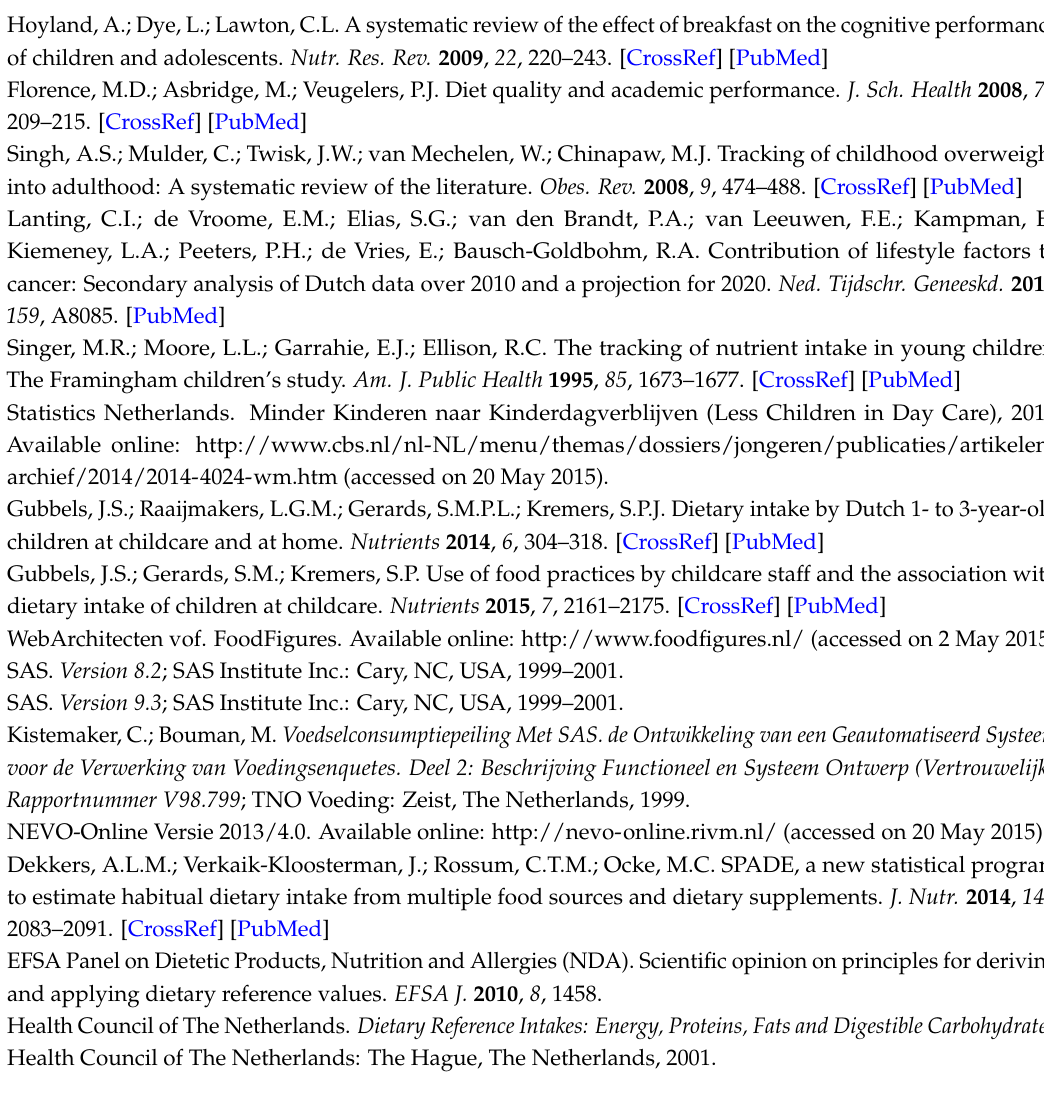
Figure S1: Consumption of foods by 1–3 years old by location, Table S1: Mean daily nutrient intake by children 10–48 months old attending childcare by gender (mean of 2 days), Table S2: Distribution of usual nutrient intake as calculated with SPADE model for daily intakes and comparison of the distribution with dietary reference